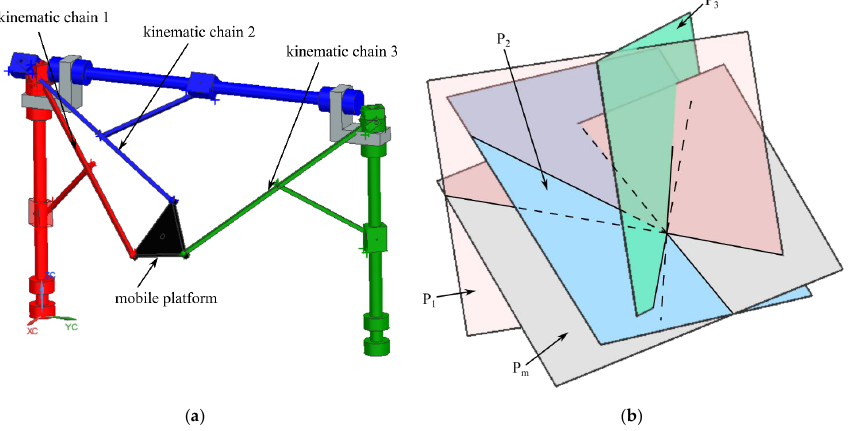
Figure 7. Type II singularity of the 6-DOF parallel robot for SILS (case 1—the characteristic tetrahedron faces and base intersect in a point): ( a ) parallel robot pose; ( b ) characteristic planes intersect in a point.